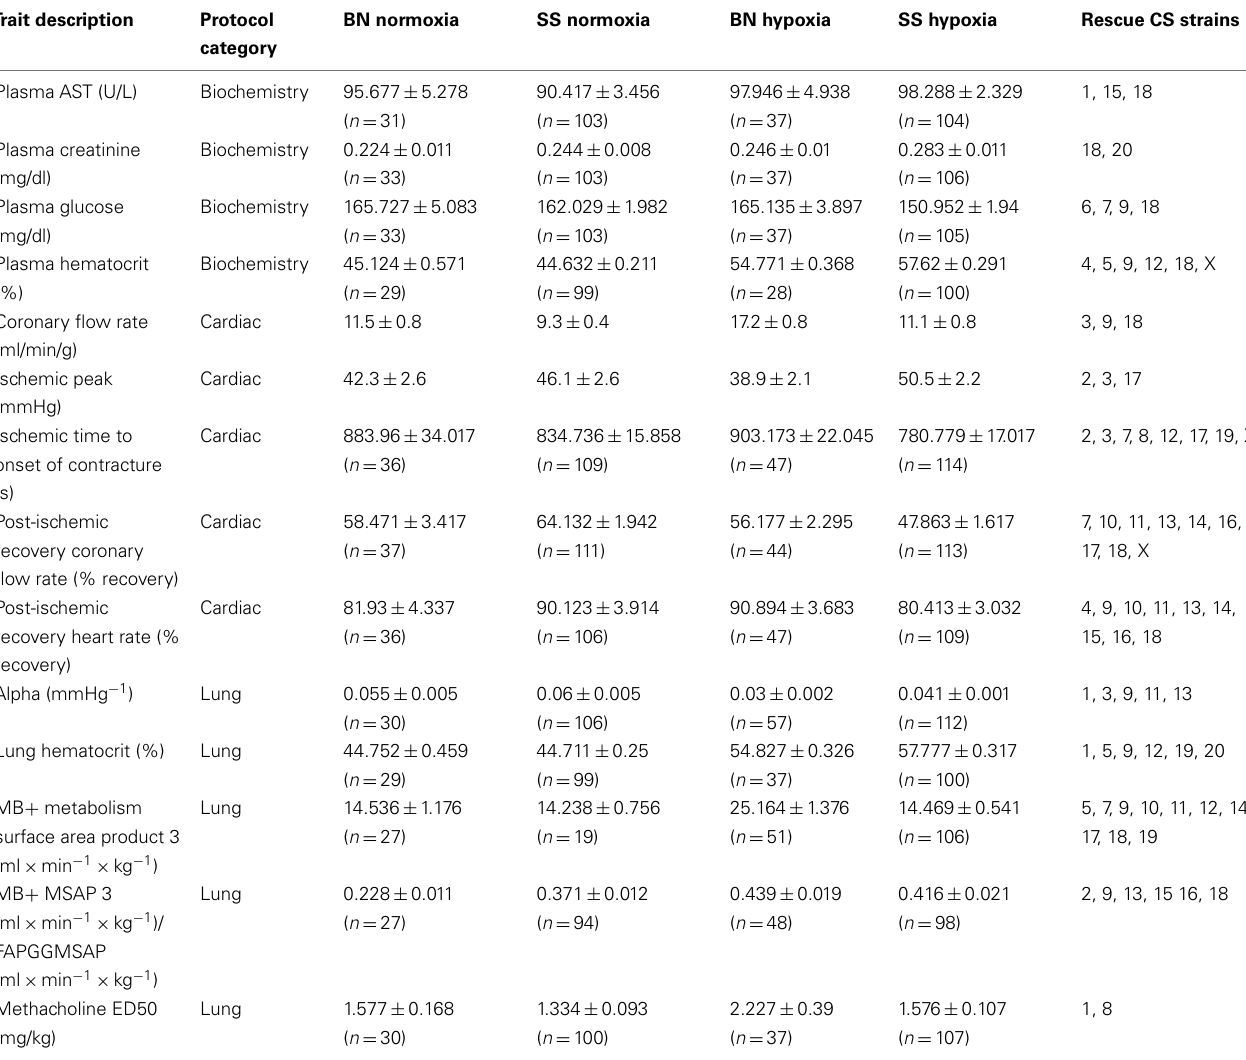
Table 1 | Phenotypic responses of SS and BN parental strains in respect to O 2 partial pressure (12 or 21% sO 2